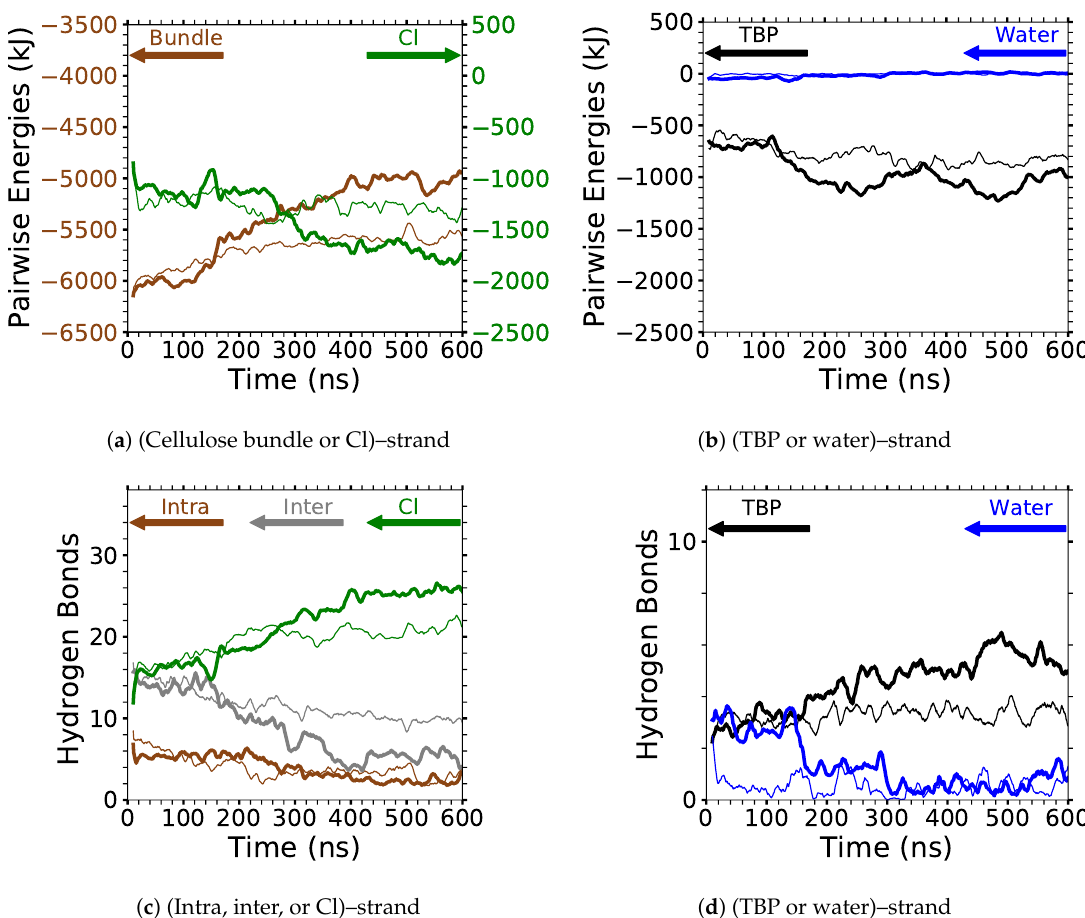
Figure A14. Pairwise energies and hydrogen bonding of the peeling strand(s) at 63.1mol%water and 360K. The pairwise energies of the separating strand(s) between the: ( a ) (cellulose bundle or Cl)–separating strand; ( b ) (TBP or water)–separating strand. The number of hydrogen bonds for the separating strand(s) per the given type: ( c ) (intra, inter, or Cl)–separating strand; ( d ) (TBP or water)–separating strand. The thick line is the first yellow strand to peel, and the thin line is the non-peeling yellow strand or second strand to peel. If neither of the stands peel, then both the thick and thin lines are non-peeling yellow strands. The data were averaged over 1000 data points, using a rolling